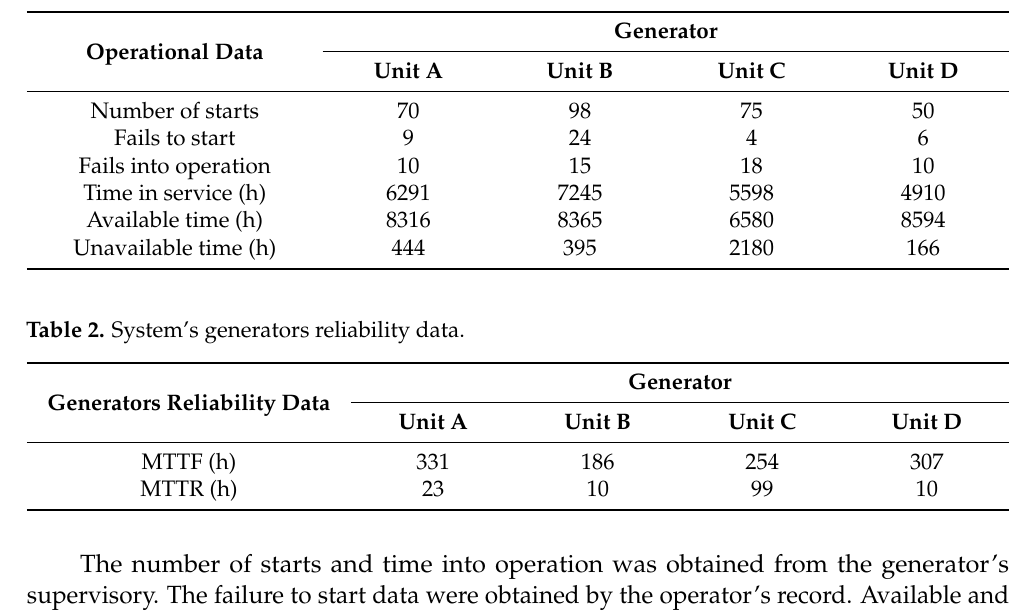
Table 1. System’s generators operational data.